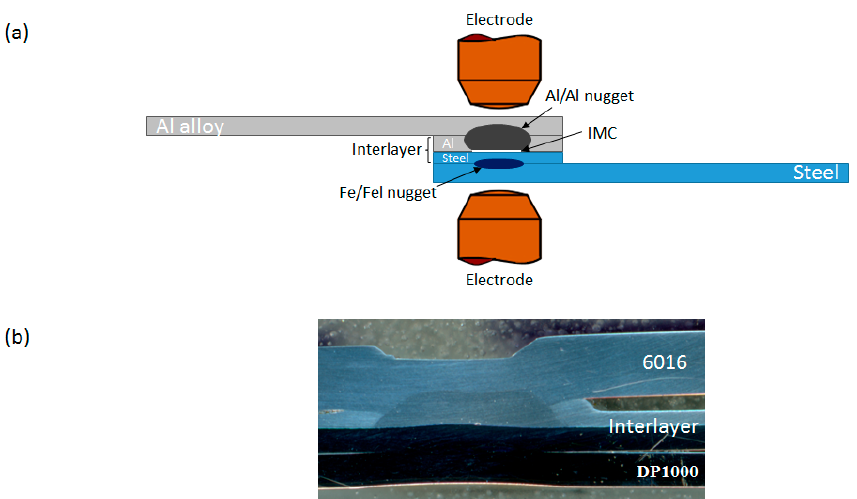
Figure 6. ( a ) Schematic illustration of a bimetallic strip used as transition joint between aluminum and steel sheets. The white line on the Al alloy/steel interface evidence the IMC formation region. ( b